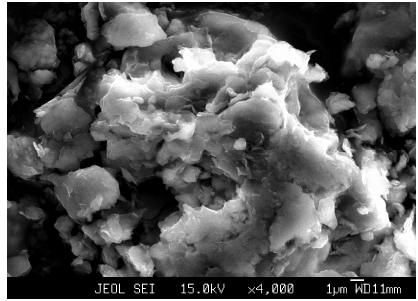
Figure 2. Scanning electron microscope picture of virgin